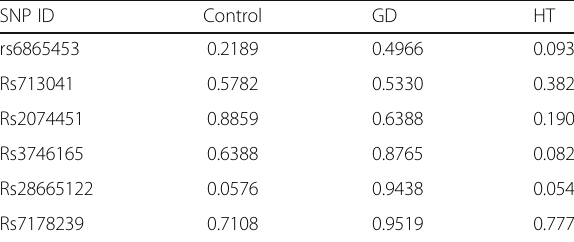
Table 2 Hardy-Weinberg P value of the six SNPs SNP ID